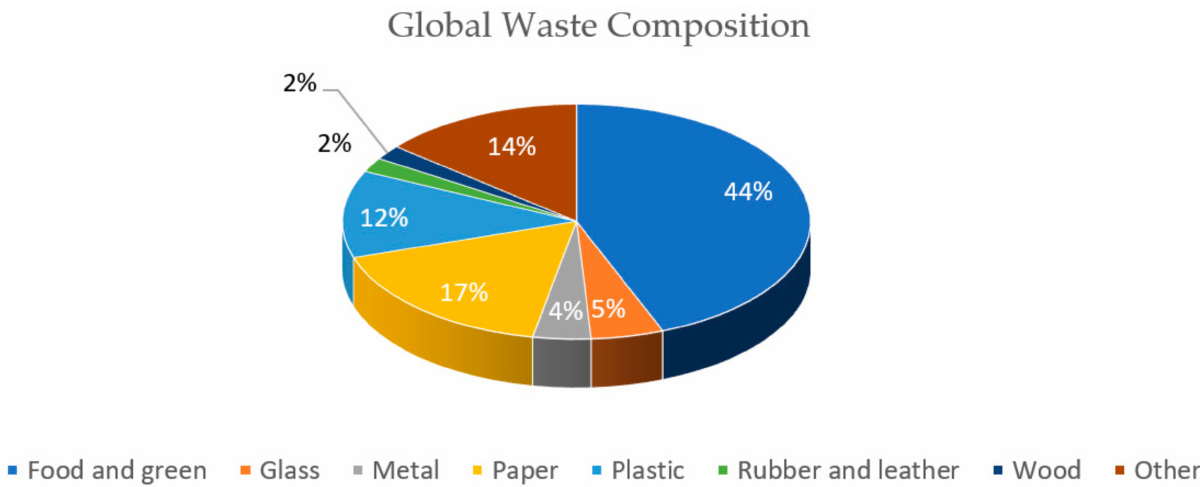
Figure 1. Percentage of global waste